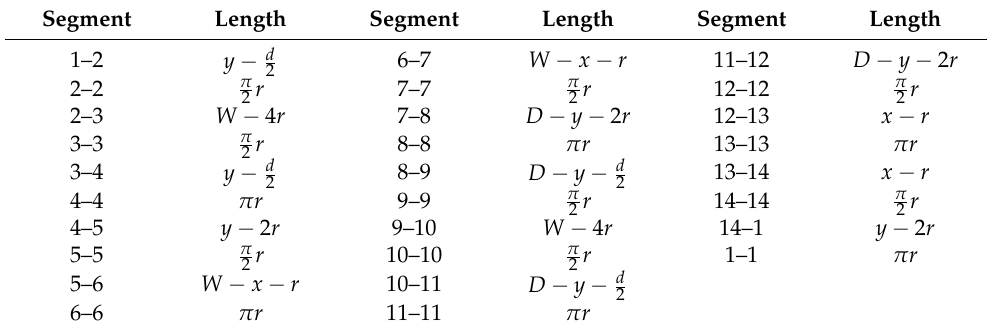
Table 1. Length of each belt segment, for the CoreH-bot schematic in Figure 6c: the segment i – j connects the i -th and the j -th pulley, while the segment i – i wraps (for either 90 ◦ or 180 ◦ ) on the i -th